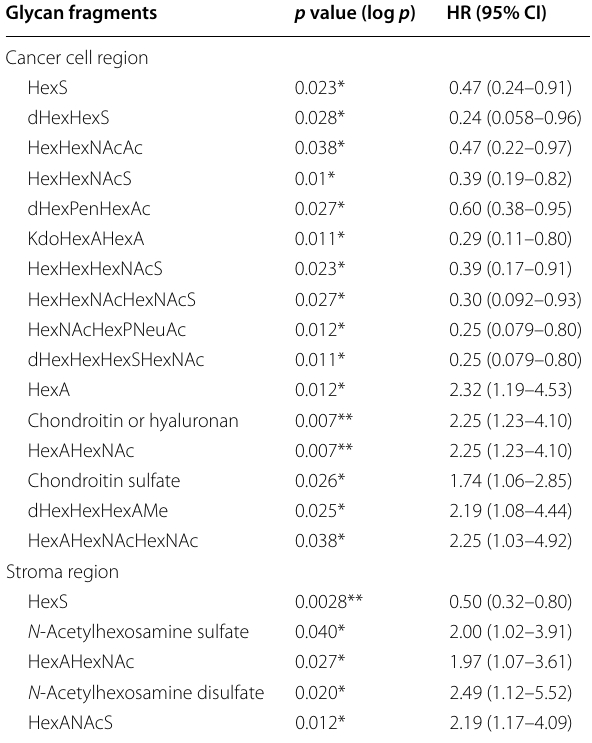
Table 3 Univariate cox proportional hazard modeling (K–M